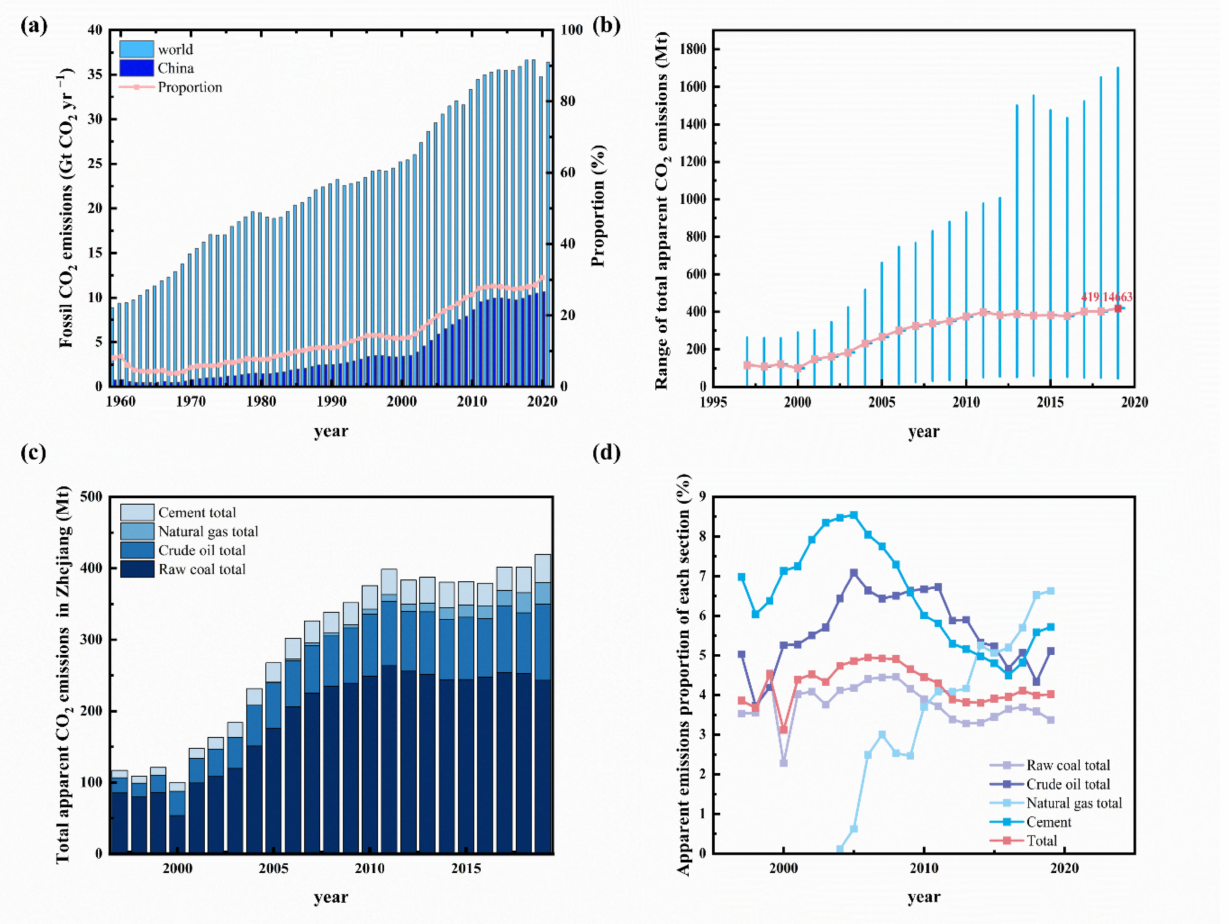
Figure 1. CO 2 emissions. ( a ) Fossil CO 2 emissions of the world from 1956 to 2021 and China from 1956 to 2020. The line shows the proportion of fossil CO 2 emissions in China to that in the world. Data source: The data from 1956 to 2020 was obtained from the Global Carbon Project (https://doi.org/10.18160/gcp-2021, accessed on 1 May 2022) and the fossil CO 2 emissions of the world in 2021 were obtained from the Global Carbon Budget 2021 [1]. ( b ) Range of total apparent CO 2 emissions by province in China from 1997 to 2019. The red line represents the situation in Zhejiang. ( c ) The current situation for CO 2 emissions in Zhejiang Province is divided into several sections. ( d ) The percentage of each section for Zhejiang Province in China from 1997 to 2019 (source: https://www.ceads.net.cn, accessed on 22 April